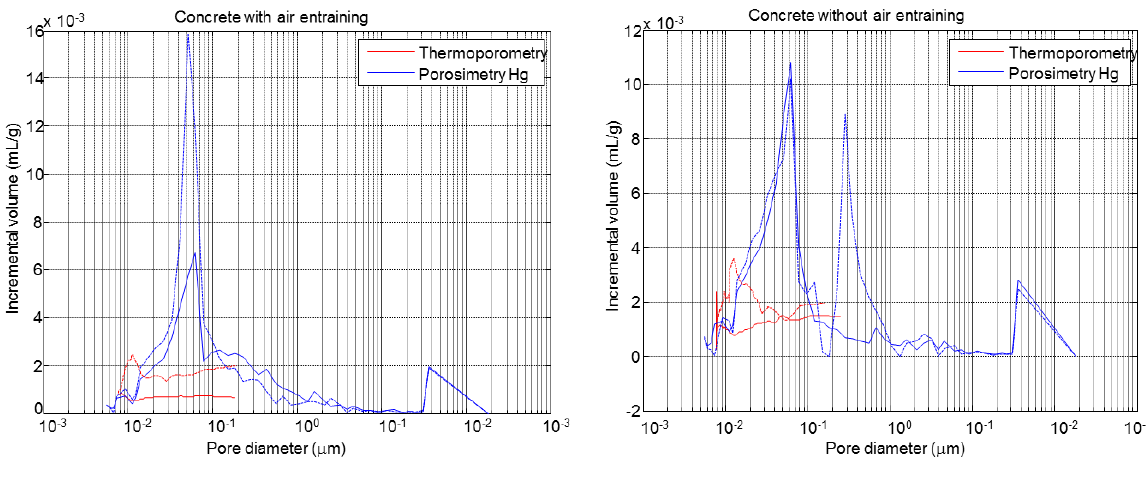
Figure 21. Distribution of pore size from mercury porosimetry and thermoporometrical model (solid line means “before cycles”; dashed line means “after